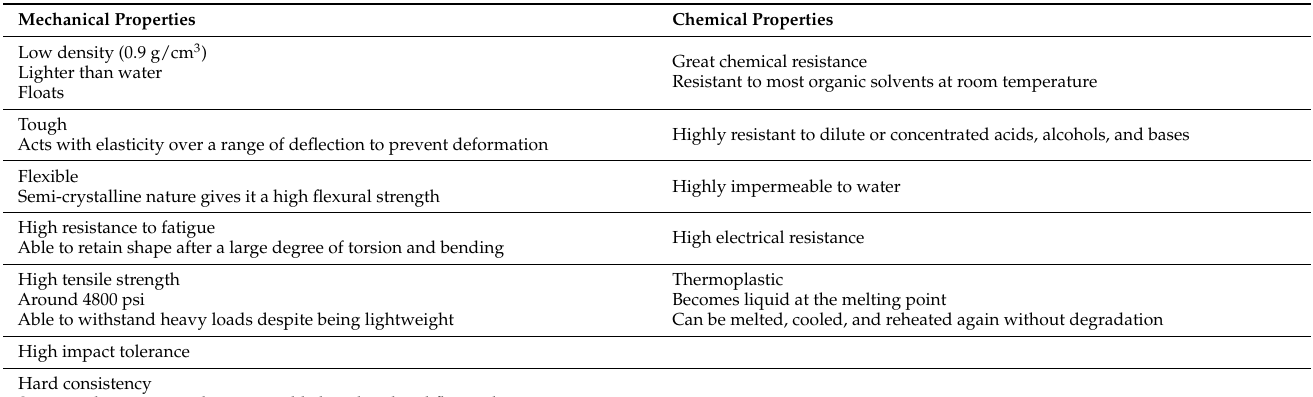
Table 2. Summary of the mechanical and chemical properties of polypropylene material in its standard form. Note that the method of fabrication can significantly affect material